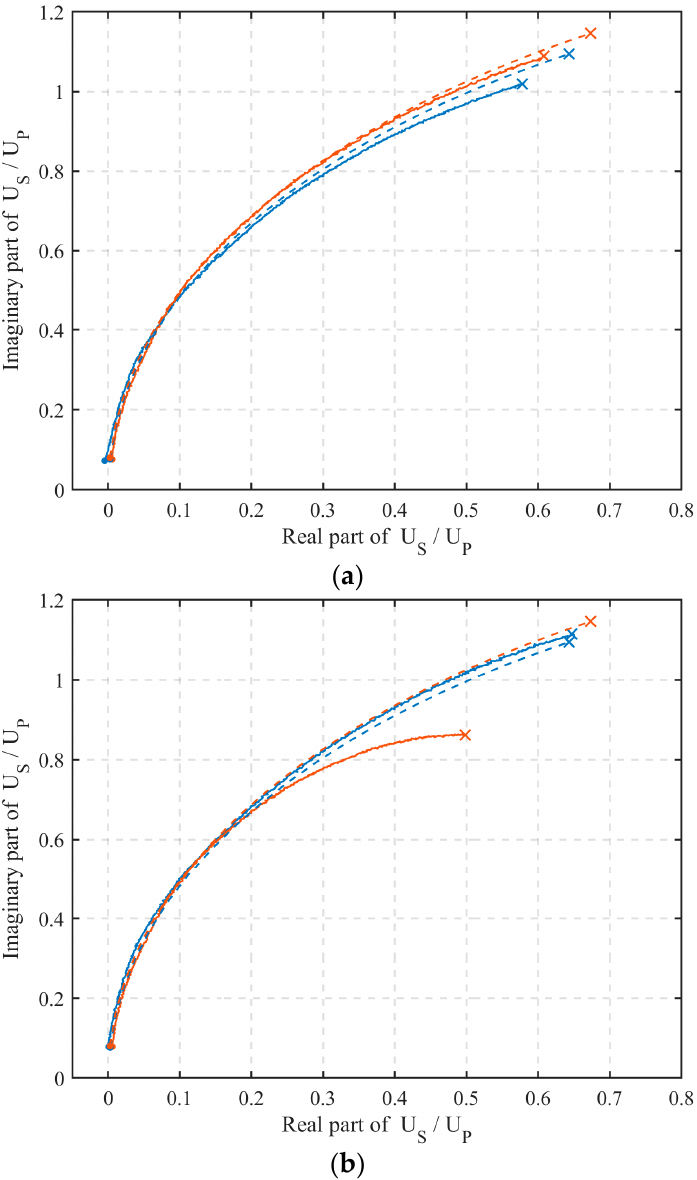
Figure 15. Ratio of secondary and primary induced voltage: ( a ) TX C-2/RX C-2 configuration, ( b ) TX X-6/RX X-6 configuration. Measurement (full line) and FEM analysis (dashed lined). Transmitter orientation up (blue line) or down (red line).